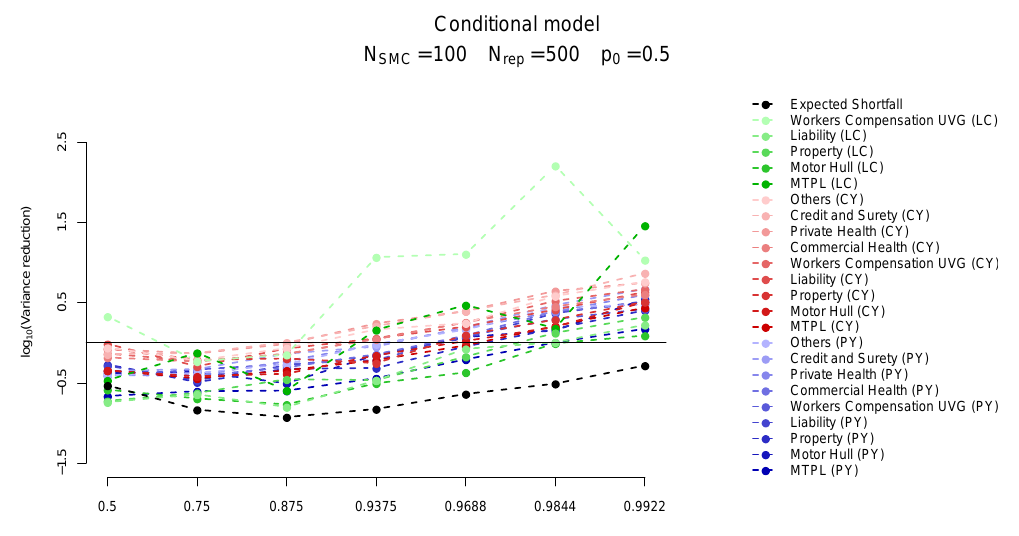
Figure 12. Variance reduction for the marginalized model.